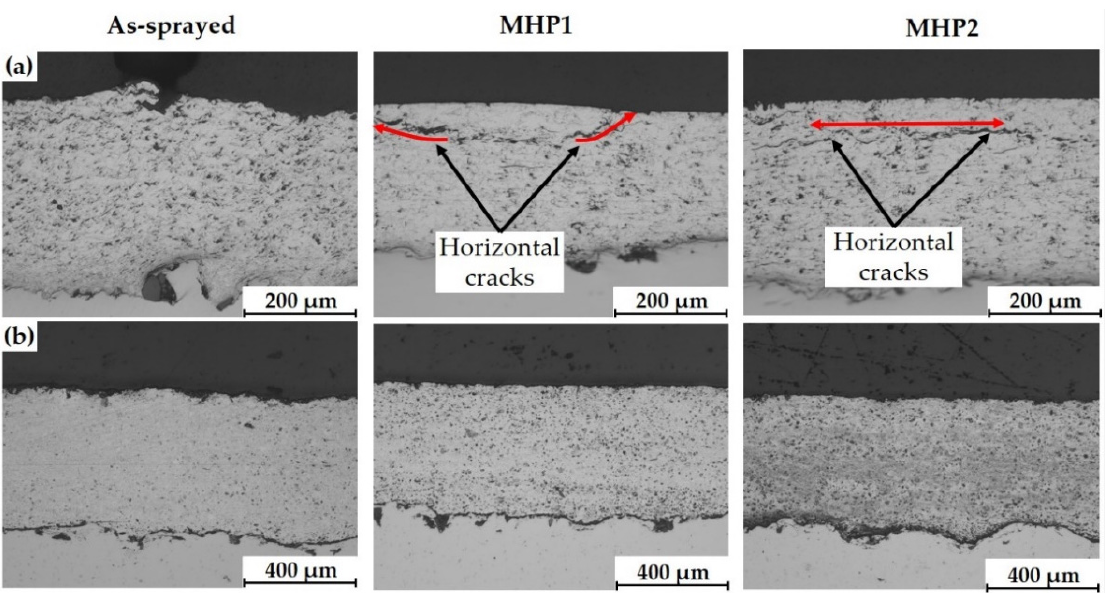
Figure 12. Machine hammer peening effect on the coating microstructure: ( a ) compressed air sprayed coatings and ( b ) argon sprayed coatings.